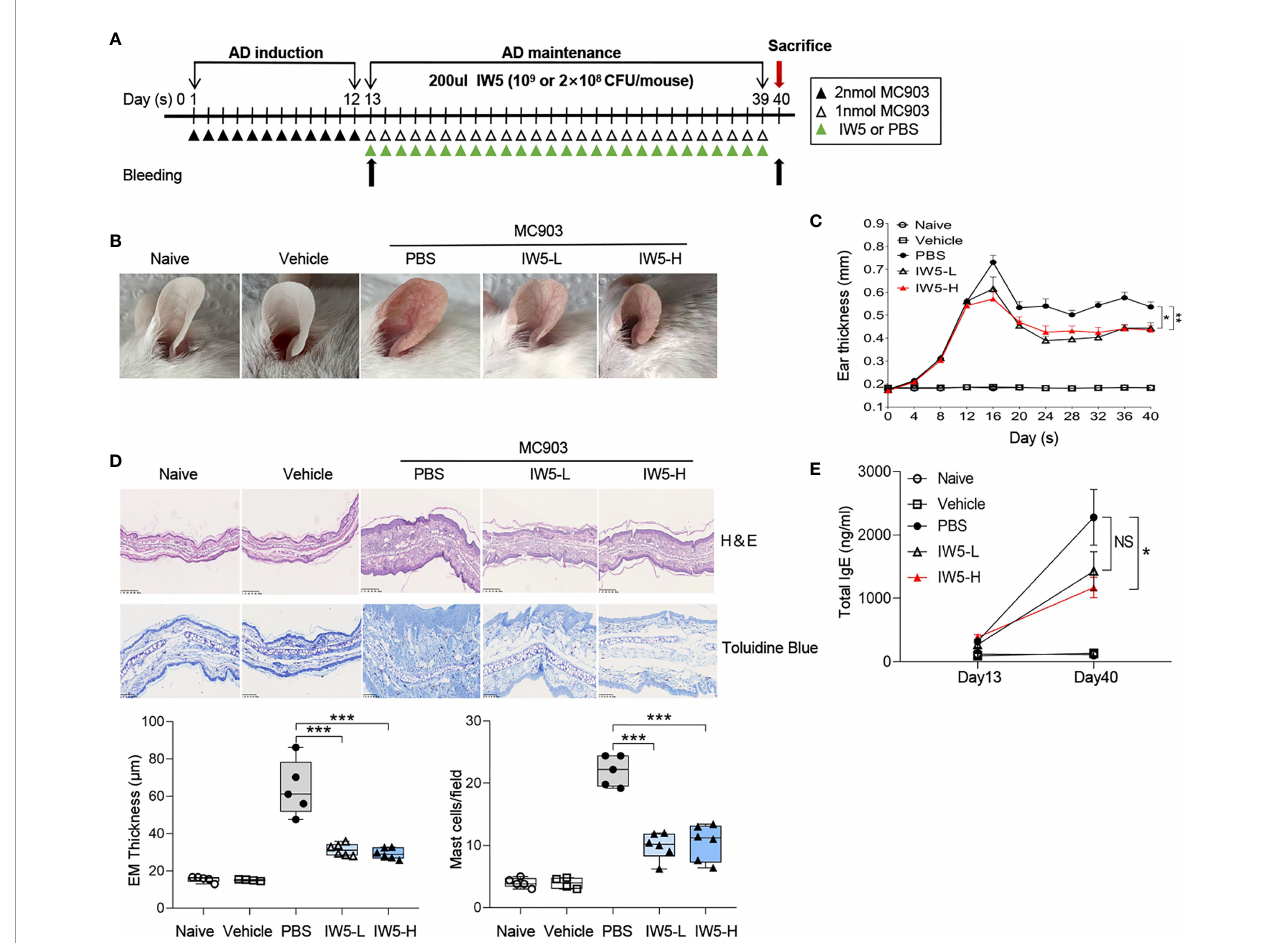
FIGURE 1 | IW5 ameliorates MC903-induced AD symptoms in mice. (A) Experimental design. Mice were topically treated with MC903 for 12 days and then gavaged with IW5-L (2 × 10 8 CFU IW5), or IW5-H (10 9 CFU IW5) daily for 27 days. Oral feeding of PBS to the MC903-treated mice was used as control for probiotics, and mice with EtOH painted on the ears were used as vehicle control for the MC903-induced AD model. (B) Gross appearance of the ears on day 40. (C) Dynamic changes of ear thickness at the indicated time points. (D) Histology of skin lesion. Hematoxylin and eosin (H&E) staining shows the thickness of the epidermis (EM) (original magni fi cation ×100, Scale bar = 250 m m), and toluidine blue staining shows the in fi ltration of mast cells (original magni fi cation ×200, Scale bar = 100 m m). (E) Levels of serum total IgE at day 13 and day 40 as measured by ELISA. Data are shown as means ± SEMs, and representative of data from